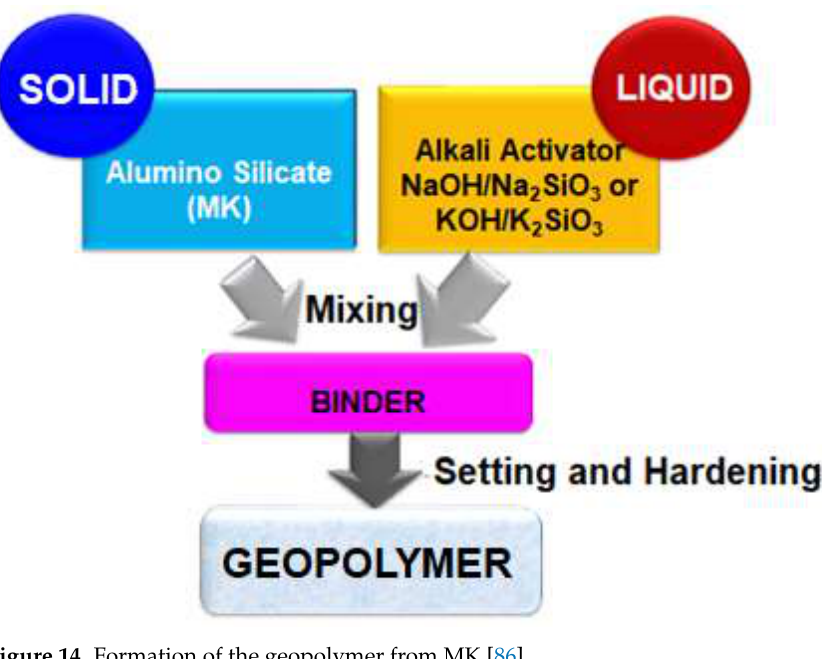
Figure 14. Formation of the geopolymer from MK [86].